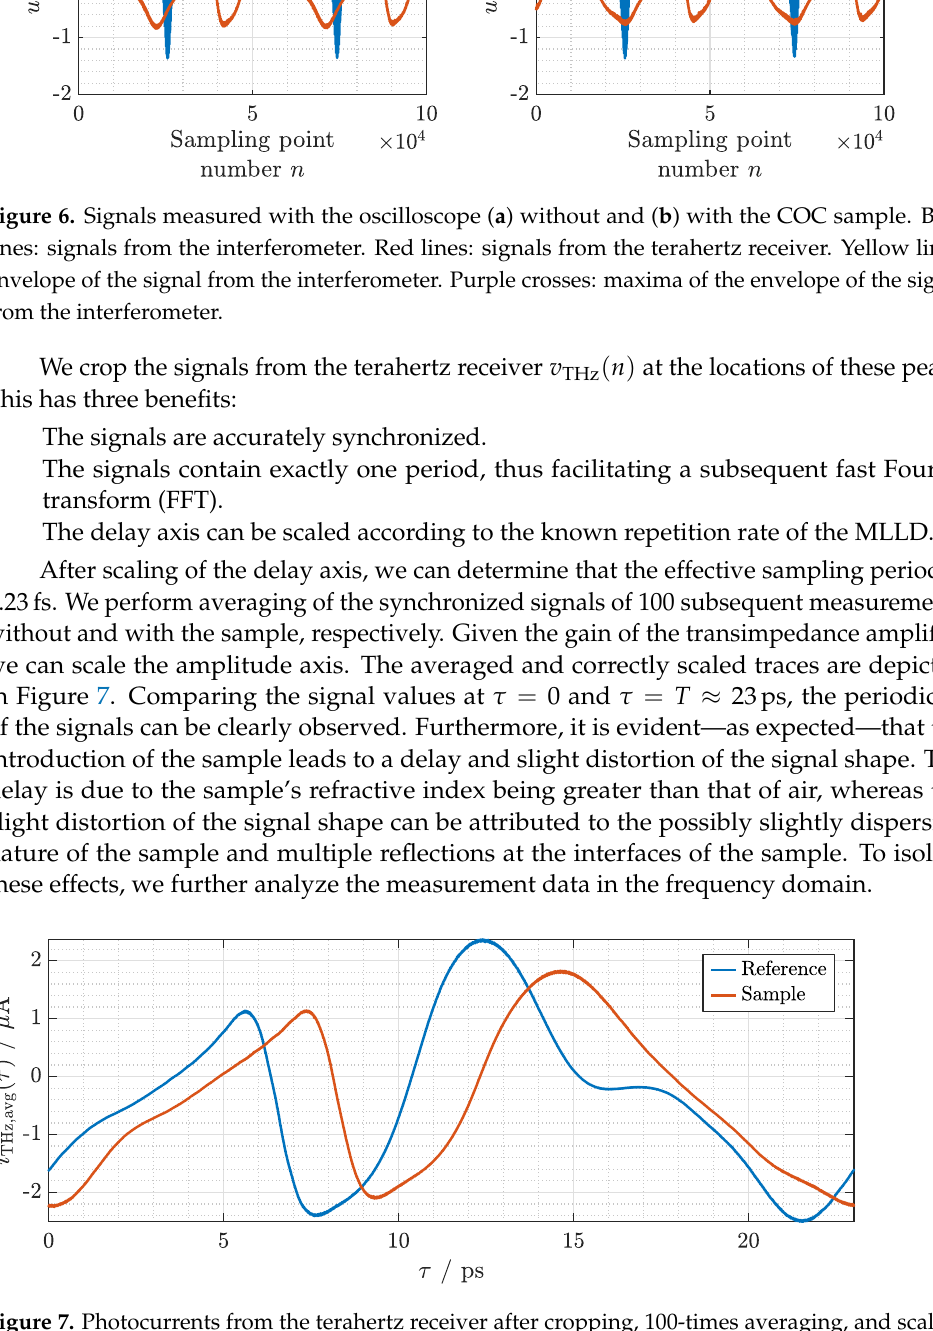
Figure 7. Photocurrents from the terahertz receiver after cropping, 100-times averaging, and scaling of the delay and amplitude axes. Blue: without the sample. Red: with the COC